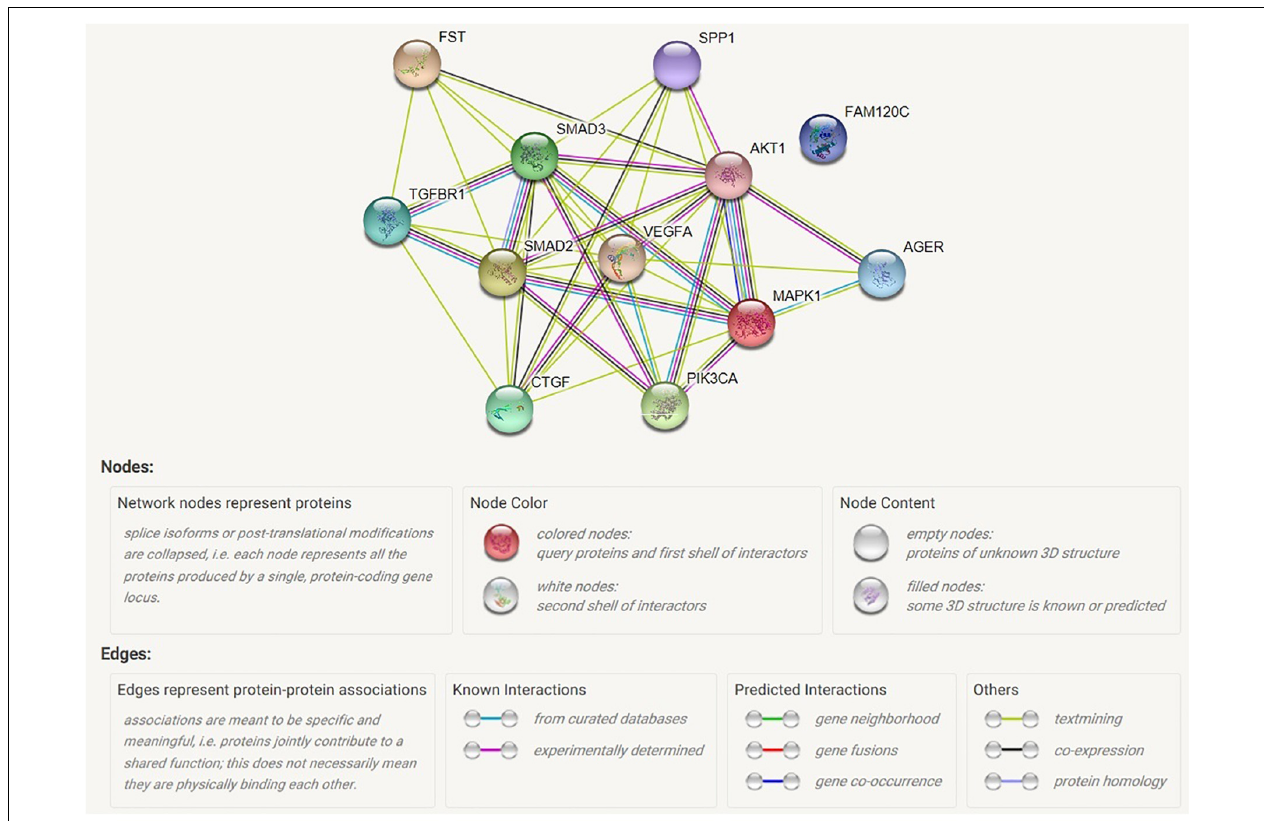
FIGURE 8 | Map of possible interaction between selected genes. AGER, advanced glycosylation end product-specific receptor; AKT1, serine/threonine kinase 1; CTGF, connective tissue growth factor; FAM120C, family with sequence similarity 120C; FST, follistatin; MAPK1, mitogen-activated protein kinase 1; PIK3CA, phosphatidylinositol; SMAD2, mothers against decapentaplegic homolog 2; SMAD3, mothers against decapentaplegic homolog 3; SPP1, secreted phosphoprotein 1; TGFBR1, TGF-beta receptor type-1; VEGFA, vascular endothelial growth factor